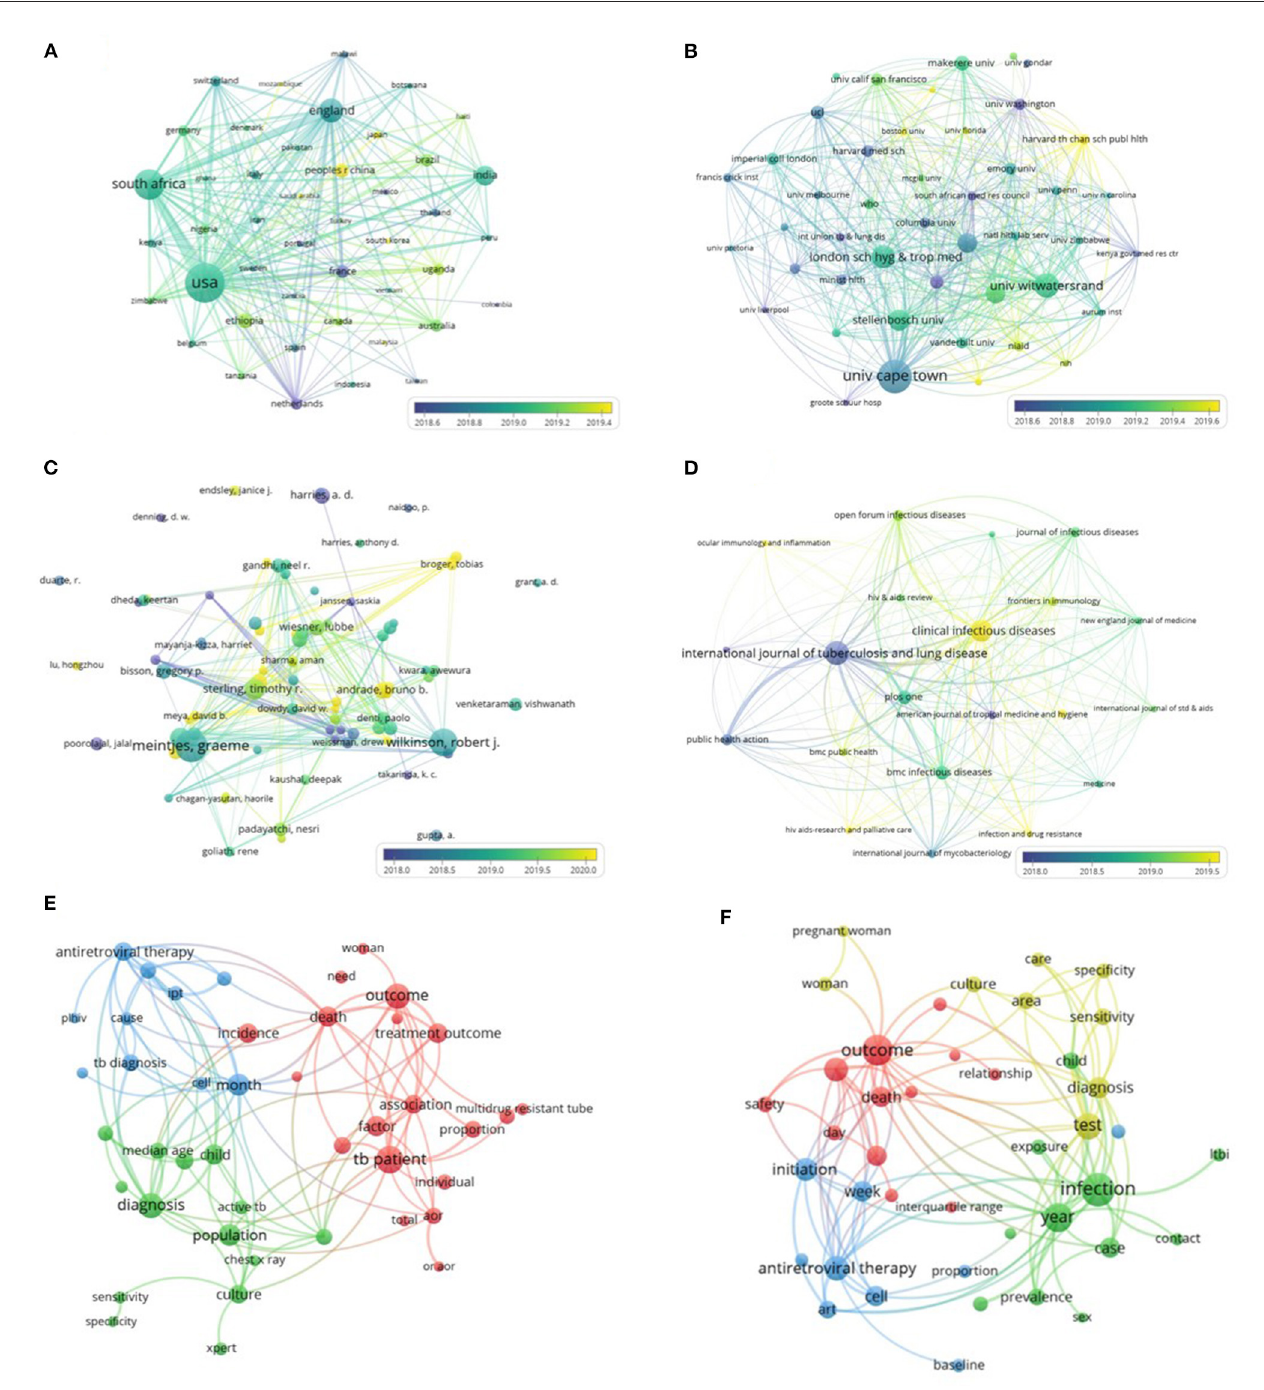
FIGURE3 The distribution of countries, institutions, authors, and journals on HIV-MTB co-infection research. (A) Map of countries with publications on HIV-MTB co-infection. (B) Map of institutions with publications on HIV-MTB co-infection. (C) Map of authors with publications on HIV-MTB co-infection. (D) Map of journals with publications on HIV-MTB co-infection. (E) The keywords of articles about HIV-MTB co-infection published by Int J Tuberc Lung Dis . (F) The keywords of articles about HIV-MTB co-infection published by Clin Infect Dis . The nodes represent the countries, institutions, authors, and journals. The depth of color represents the publication year of the included articles. The size of the dot represents the number of publications. The thickness of the connecting lines represents the strength of collaboration in the countries, institutions, authors, and journals.